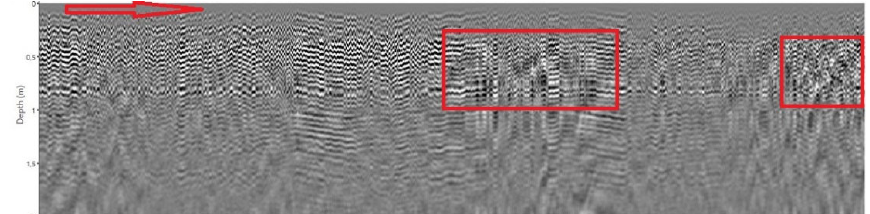
Figure 11. Radargram corresponding to the project, elaborated with the MK IV 3D Radar georadar model, processed with the Kontur software of the same brand. A route can be seen in which the archaeological anomalies are arranged between approximate depths of one metre.